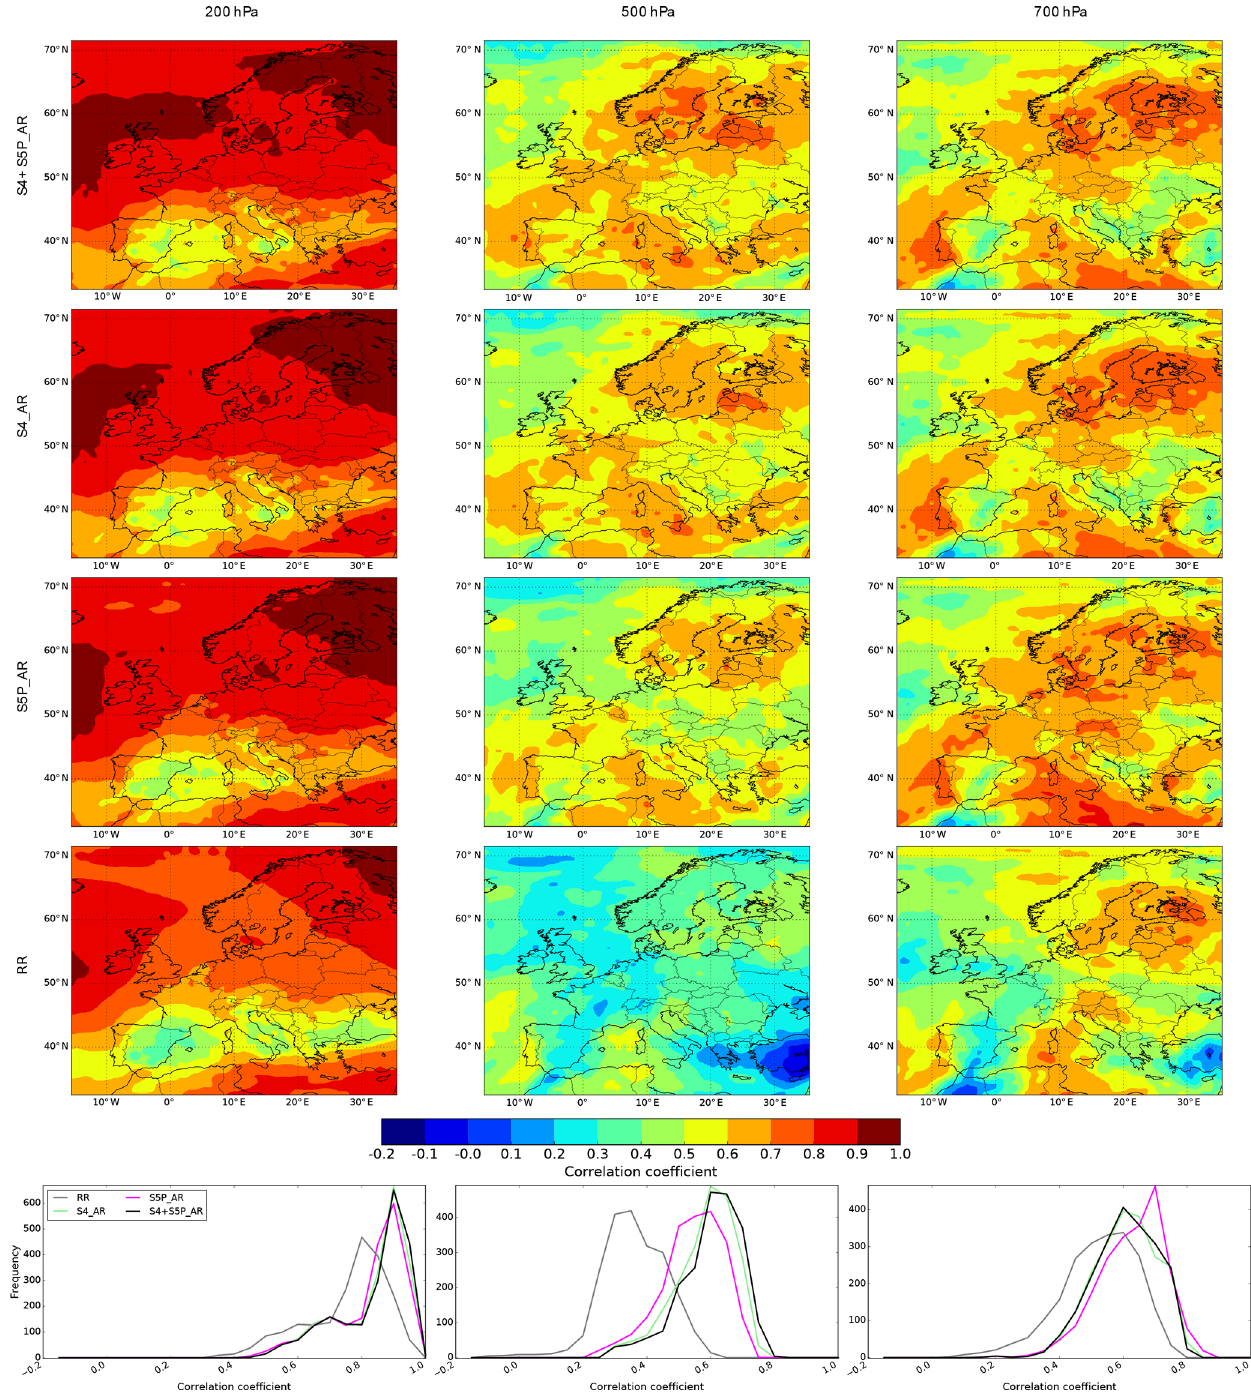
Figure 12. As Fig. 10 but for the correlation coefficient maps and histograms. Note that the colour bars are the same for the three